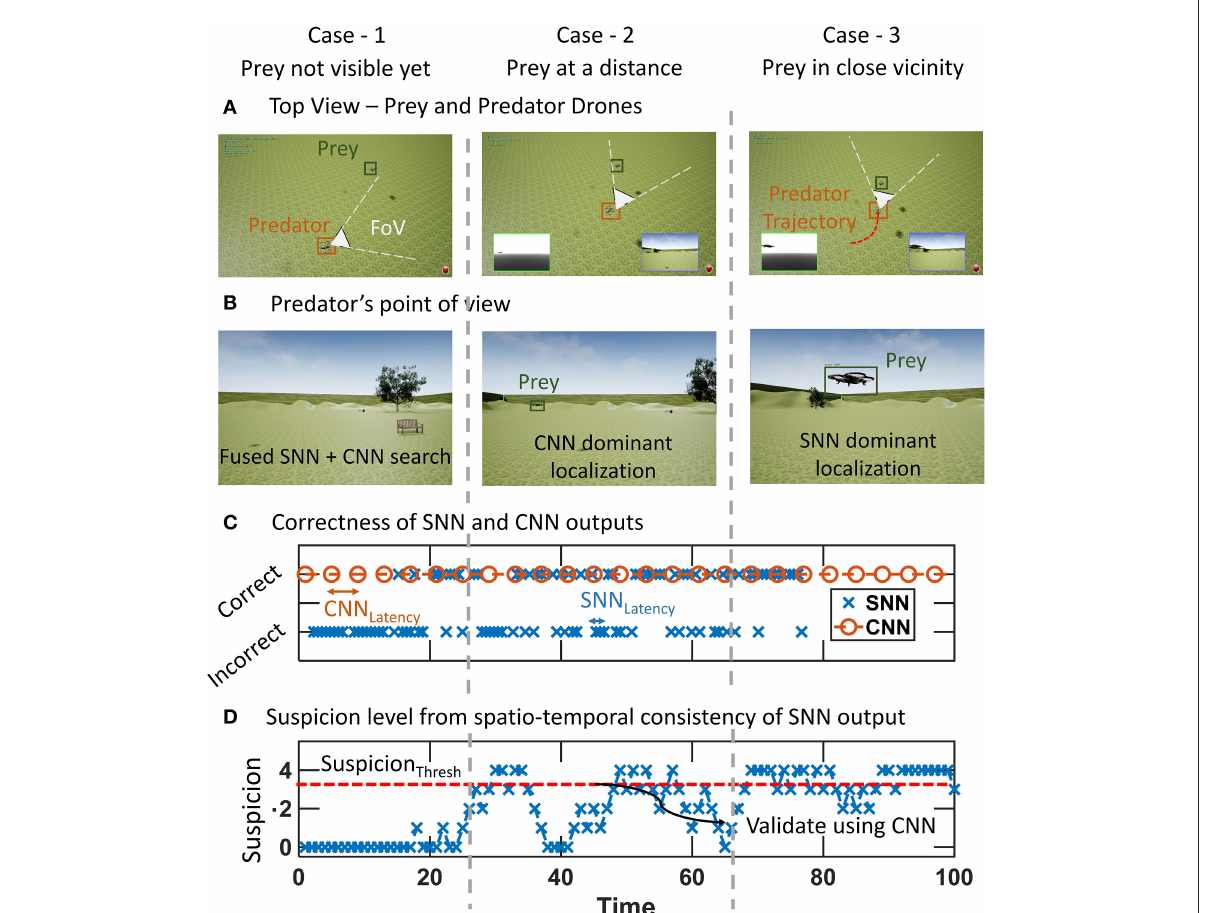
FIGURE4 Phases of chasing the prey drone as the predator passes through cases 1–3. A time step corresponds to one output of SNN and is denoted by “time” in figure. (A) Top view of the prey and predator drone positions. The prey becomes visible and is approached from case 1 to case 3.